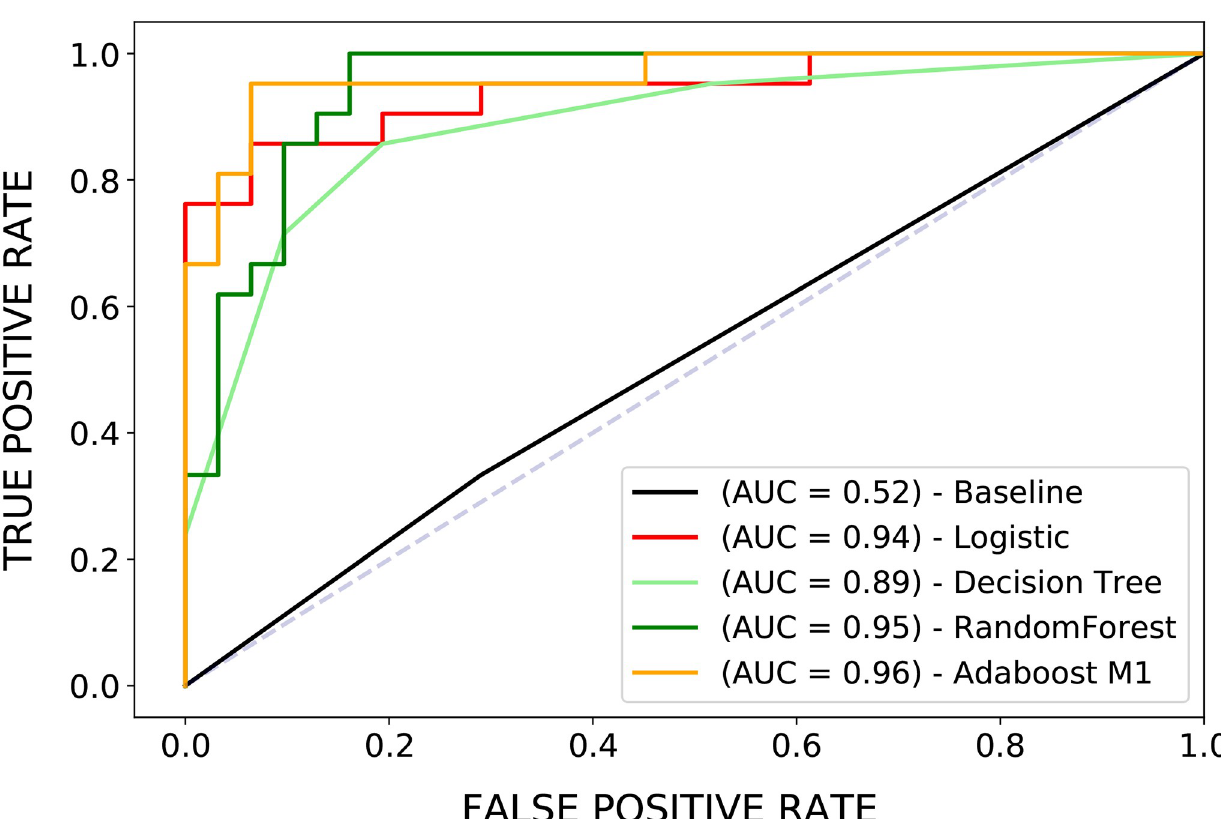
Fig 5. ROC curves for the implemented classifiers. They trace the true positive rate and the false positive rate as the probability threshold changes, i.e., the threshold beyond which an observation is assigned to class 1 (male team). When the true positive rate and the false positive rate are 0, the threshold is 1 (all the observations are classified as class 0) [29]. In this case, the true positive rate is the percentage of male teams correctly classified, and the false positive rate is the percentage of female teams mistaken as male, using a given threshold. The actual thresholds are not shown. The AUC represents the area under the curve; the larger the AUC, the better the classifier [29]. Random Forest and Adaboost M1 show the best predictive performance.